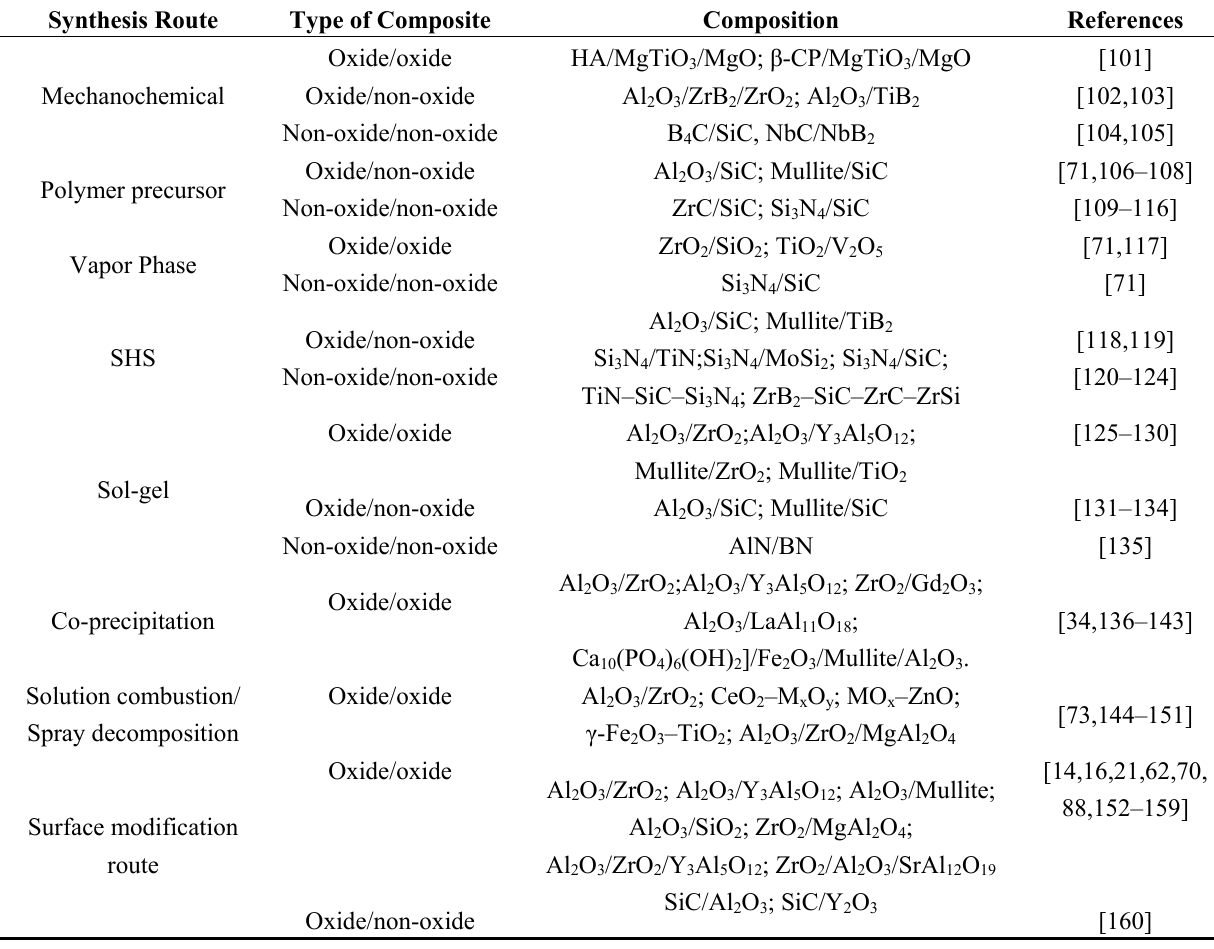
Table 1. Synthesis methods of nanocomposite ceramic powers and examples of developed